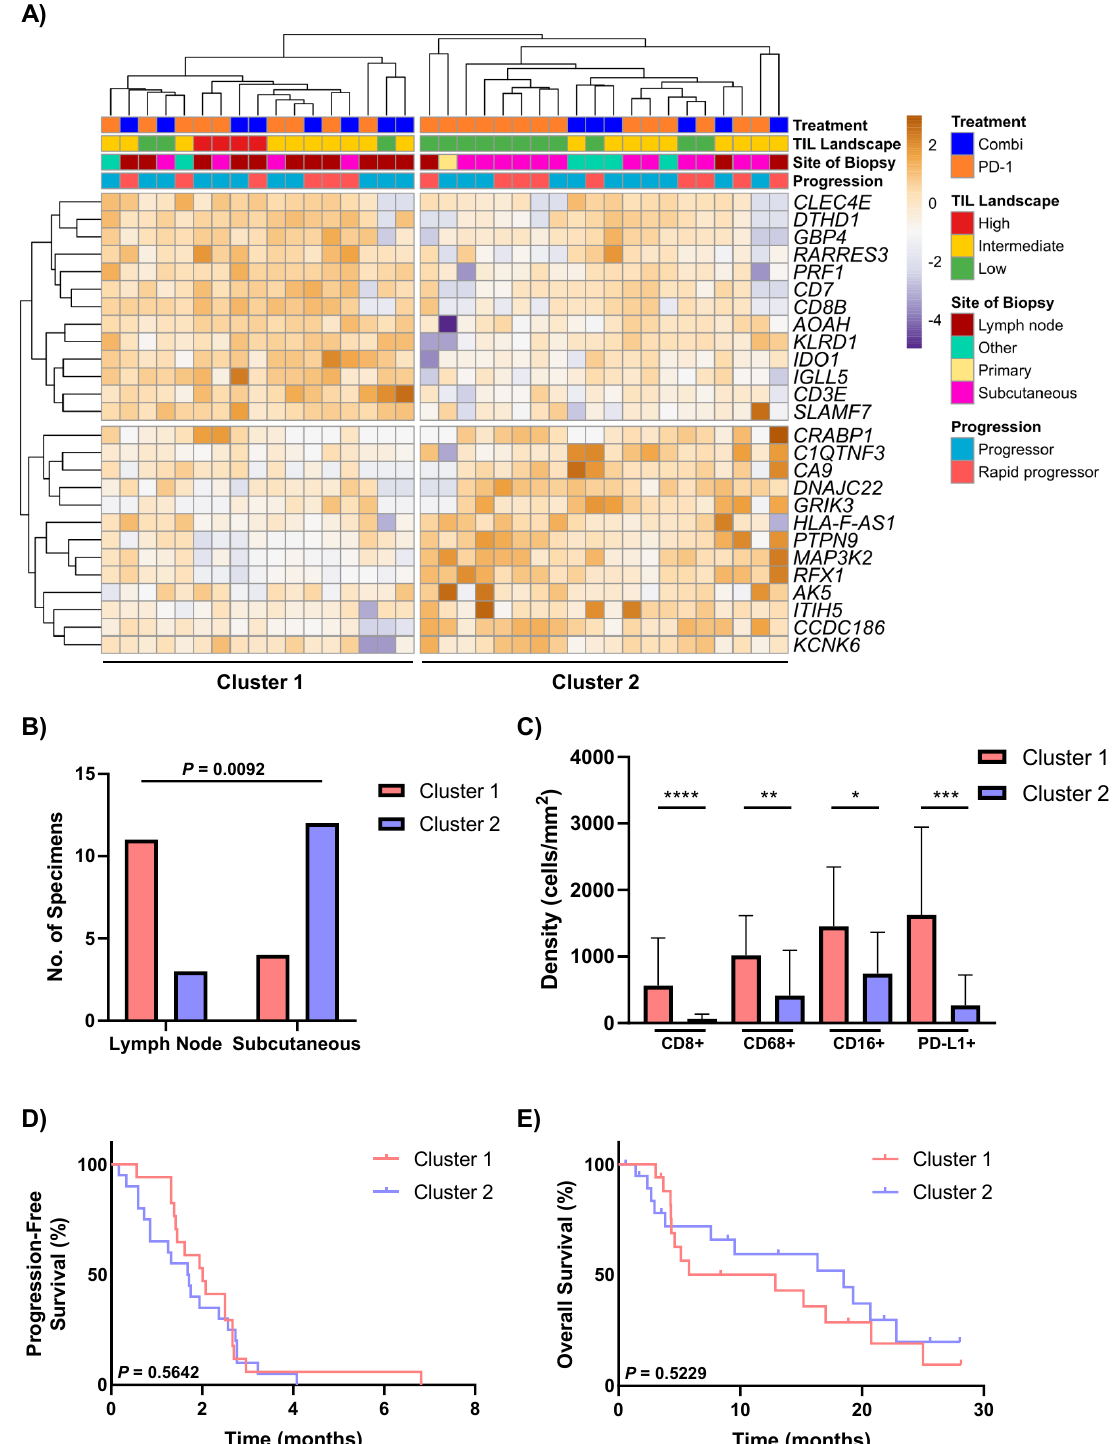
Figure 3. Gene expression profiles of non-responders to anti-PD-1-based therapies. ( A ) Unsupervised hierarchical clus- tering of 26 differentially expressed genes (DEG) in non-responders to anti-PD-1-based therapies. ( B ) Comparison of the proportions of lymph node and subcutaneous samples between DEG Cluster 1 and Cluster 2, assessed using the Fisher’s exact test. ( C ) Bar graphs comparing the densities of intratumoural immune cell populations (CD8, CD68, CD16 and PD-L1) between patients in DEG Cluster 1 ( n = 13) and Cluster 2 ( n = 15). Kaplan–Meier curves illustrating no significant differences in ( D ) progression-free survival or ( E ) overall survival between Cluster 1 and Cluster 2. Error bars represent mean ± SD. * p < 0.05, ** p < 0.01, *** p < 0.001, **** p <